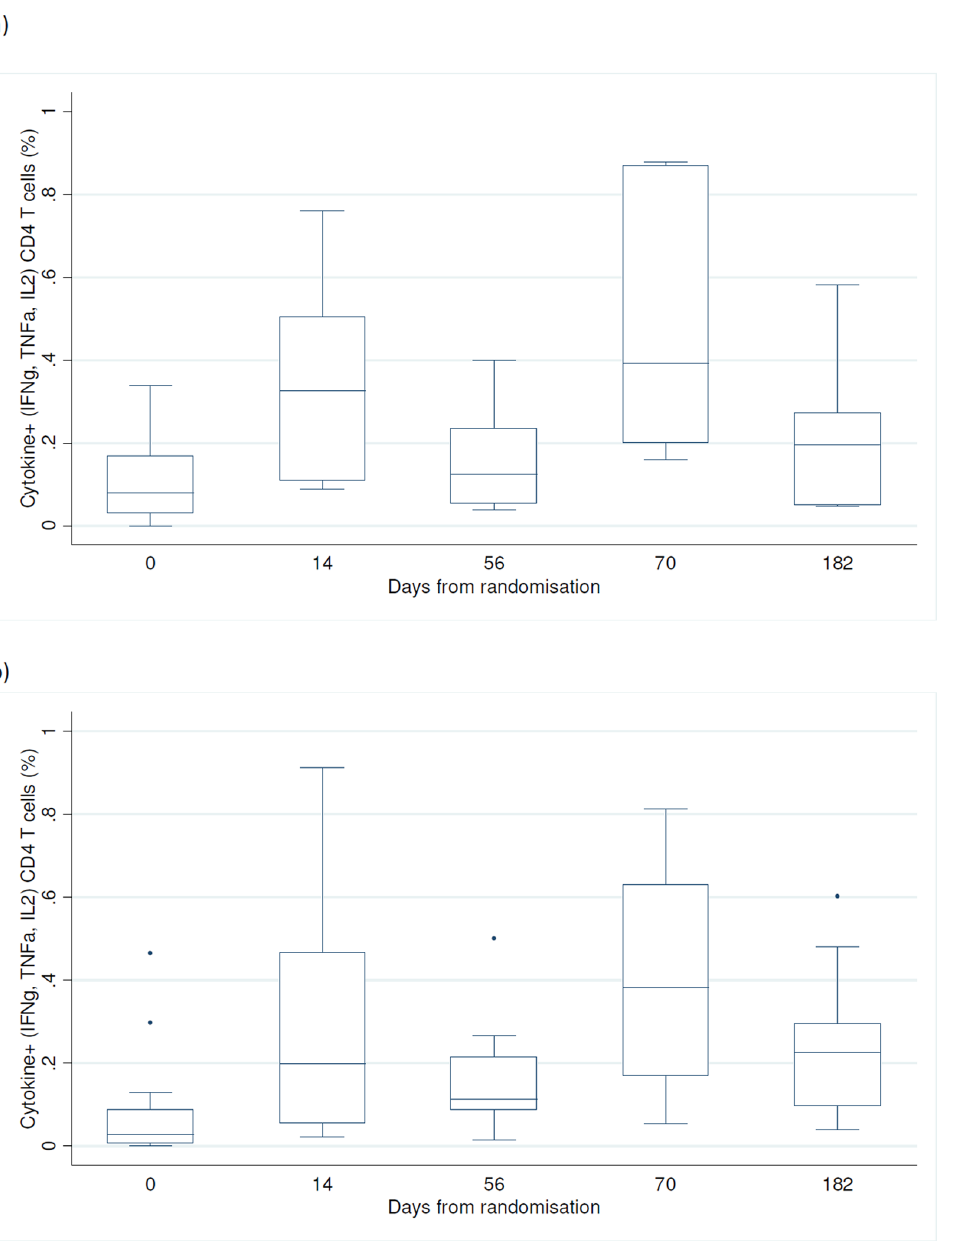
Fig. 5. Frequencies of H1 specific CD4 + T cells expressing IFN- c , TNF- a or IL-2 at day 0, 14, 56, 70 and 182, for vaccination group H1/IC31 group [unstimulated frequencies have been subtracted] for a) QFT positive n 5 6 and b) QFT negative n 5 14. Footnote: comparison of CD4 + Tcell IFN- c and/ or IL-2 and/or TNF- a responses to H1 at day 70 by those QFT positive or negative, p 5